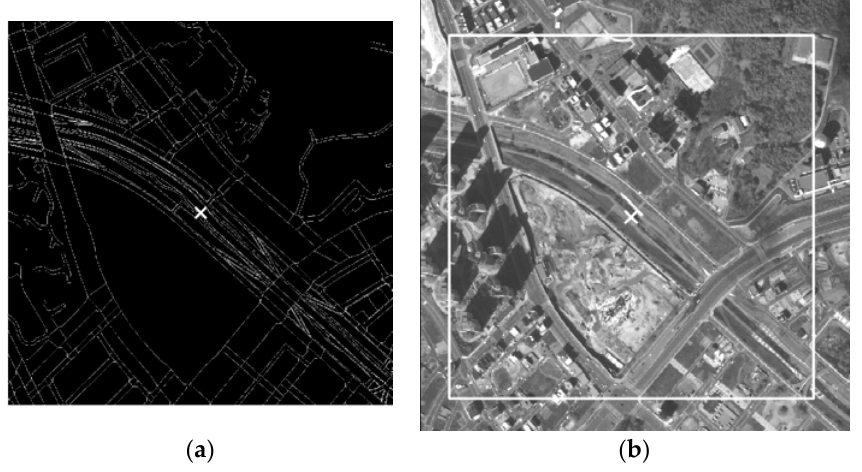
Figure 4. An RECC window matching (computed CV 4 : 1.2 pixels—average distance between the maximal RECC location and the four locations with largest RECC in ( b )). ( a ) Rasterized map layer and ( b ) matched location on a VHR image.